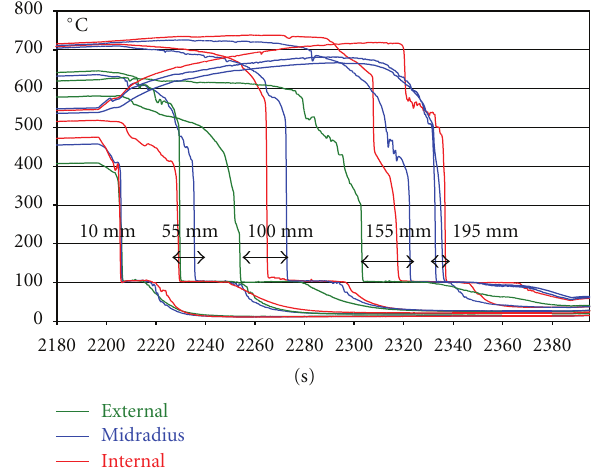
Figure 1: PRELUDE measurements of the water front evolution along time.